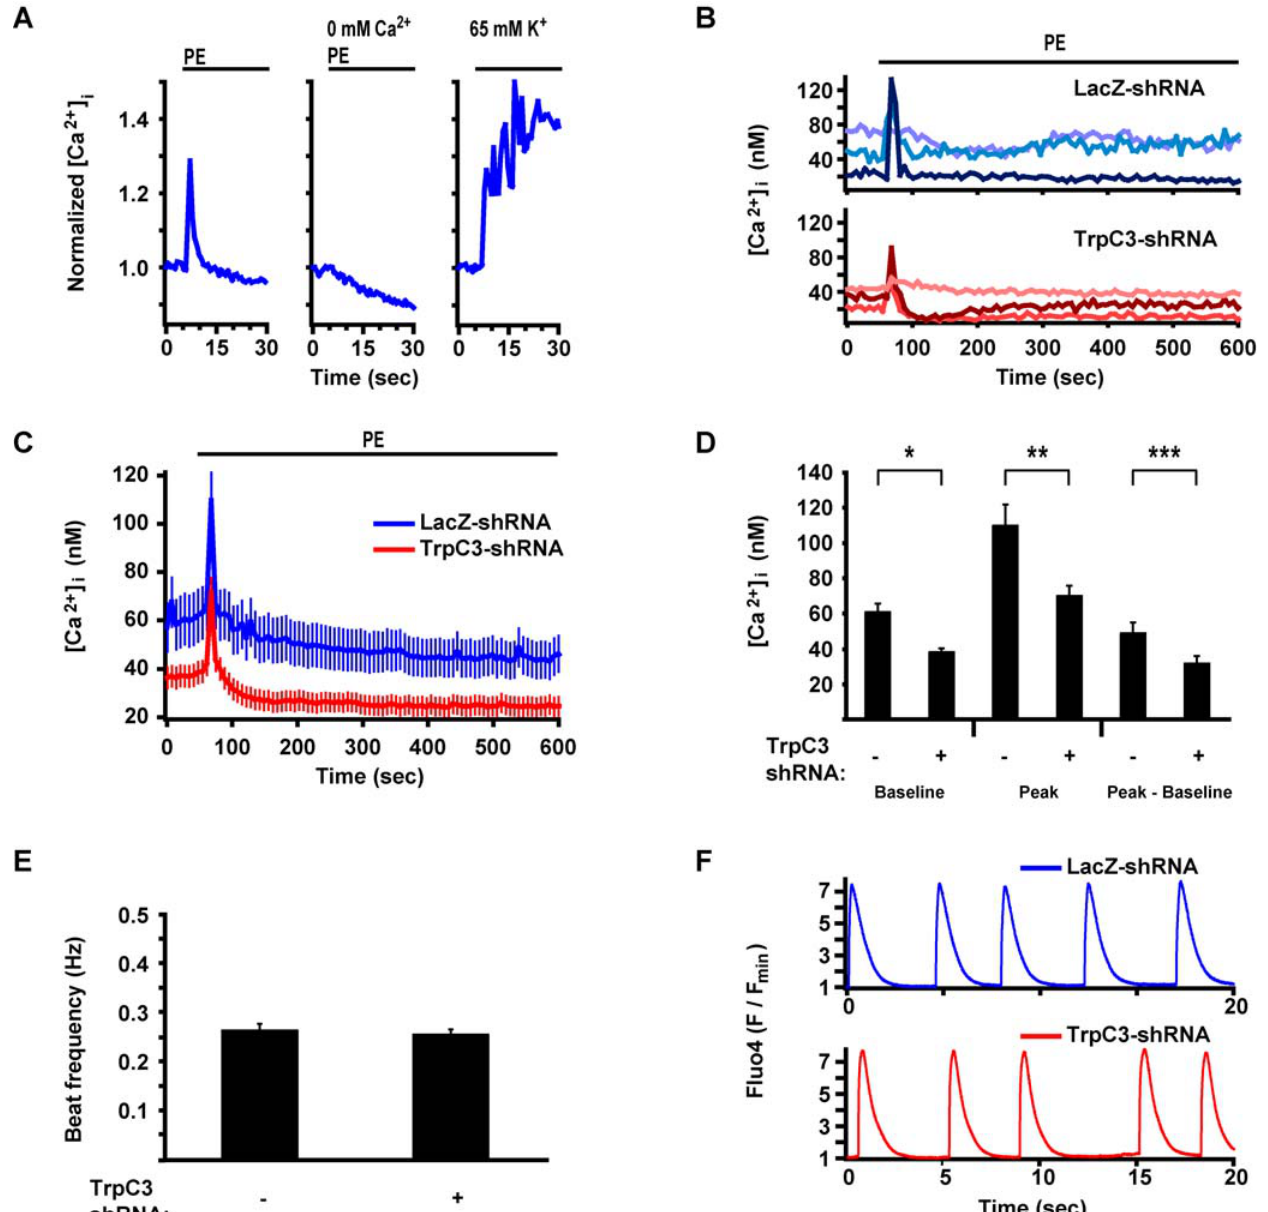
Figure 5. TrpC3 regulates baseline [Ca 2 + ] i and the PE-induced [Ca 2 + ] i elevation but does not affect beat frequency. ( A ) Mean [Ca 2 + ] i (normalized) obtained by fura-2 measurements in uninfected myocytes. Myocytes maintained in media containing 2 mM Ca 2 + and the Ca V 1.2 blocker verapamil were then stimulated with 20 m M PE (in addition to verapamil) in the presence of 2 mM extracellular Ca 2 + ( left panel , n=58 cells) or 0 mM extracellular Ca 2 + ( center panel , n=101 cells) for the time indicated by the bar at the top of the panels.. Right panel (n=58 cells), myocytes previously stimulated with PE and incubated in media containing 2 mM Ca 2 + and verapamil were then perfused with depolarizing media containing 65 mM K + and no verapamil. ( B-C ) [Ca 2 + ] i measurements in myocytes infected with lentiviruses expressing shRNAs targeting LacZ or TrpC3. Ratiometric fura-2 [Ca 2 + ] i measurements were performed on myocytes treated with verapamil and then stimulated with 20 m M PE (in addition to verapamil) for the time indicated by the bar at the top of the panels. Representative traces from single myocytes are shown in B (top panel depicts examples of individual cells expressing LacZ-shRNA; bottom panel , TrpC3-shRNA). Average traces are shown in C and represent the mean of 82 cells expressing LacZ-shRNA ( blue ) and 117 cells expressing TrpC3-shRNA (r ed ). ( D ) Mean baseline, peak, and peak minus baseline [Ca 2 + ] i of cells depicted in C . Average baseline [Ca 2 + ] i sampled at 5 time-points before treatment with PE ( columns 1 and 2 ), average amplitude of the [Ca 2 + ] i peak triggered by PE stimulation ( columns 3 and 4 ), and peak minus baseline calculated for each individual myocyte and then averaged across the population ( columns 5 and 6 ). ( E ) Spontaneous beat frequency of myocytes infected with lentiviruses expressing either LacZ- or TrpC3-shRNAs and stimulated for 48 hours with PE to induce hypertrophy. Beat frequency was measured by phase contrast microscopy in 20 wells per condition. TrpC3 shRNAs had no effect on myocyte beat frequency. ( F ) Fluo-4 measurements of [Ca 2 + ] i in spontaneously-beating myocytes expressing LacZ- or TrpC3-shRNAs and stimulated for 72 hours with PE. Calcium traces are displayed as Fluo-4 intensity values normalized by the minimum Fluo-4 value recorded from the given cell. Displayed traces are from single representative myocytes expressing either LacZ-shRNA ( top panel ) or TrpC3-shRNA ( bottom panel ). Comparing Fluo-4 calcium traces for myocytes expressing LacZ-shRNA (n=23 cells) and TrpC3-shRNA (n=23 cells) did not detect any statistical difference in beat frequency, peak:baseline ratio, or decay constants. * indicates statistically significant difference compared to control, P , 0.0001. ** indicates P , 0.005. For all bar graphs and the traces in B , data are represented as mean 6 SEM.